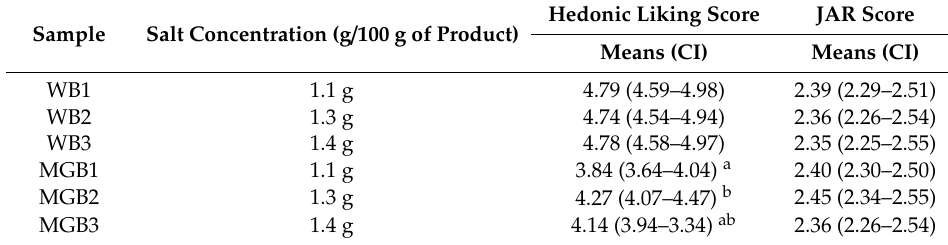
Table 2. Descriptive analysis of the hedonic liking (7-point hedonic scale) and perception of saltiness intensity (5-point just about right (JAR) scale) of the bread samples with di ff erent salt concentrations using two-way analysis of variance (ANOVA) and least significant di ff erence (LSD) ( n = 200). Hedonic Liking Score JAR Score Sample Salt Concentration (g / 100 g of Product) Means (CI) Means (CI) WB1 1.1 g 4.79 (4.59–4.98)